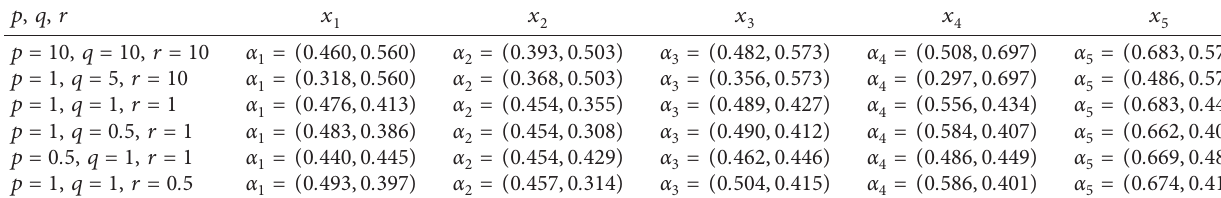
Table 3: The comprehensive evaluation value by GIFNWOGBM.